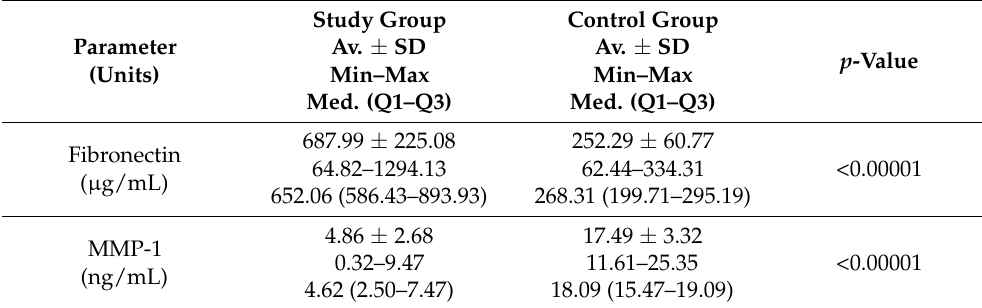
Table 2. The concentration of fibronectin and MMP-1 in the study and control group.